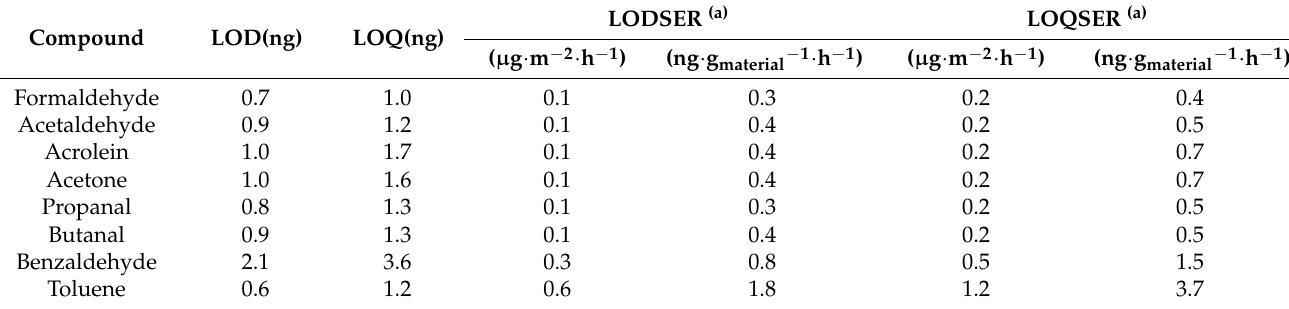
Table 2. LOD and LOQ of quantified